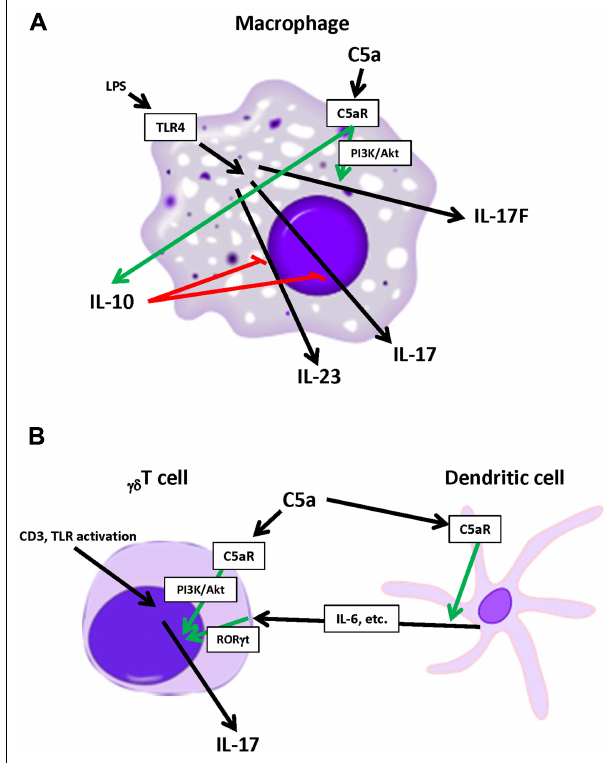
FIGURE 1 | Modulation of innate immune cell-derived IL-17 by C5a. (A) LPS-activated macrophages produce IL-17, IL-17F, and IL-23. C5aR activation has been shown to enhance IL-17F while reducing IL-17 and IL-23 production by macrophages. (B) Activated γδ T cells produce IL-17 which is enhanced directly or indirectly by